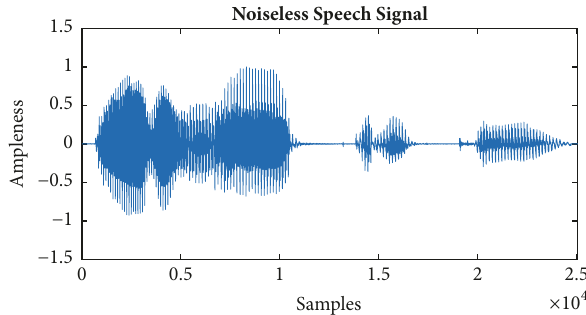
Figure 1: Noiseless signal used for comparison with the estimated